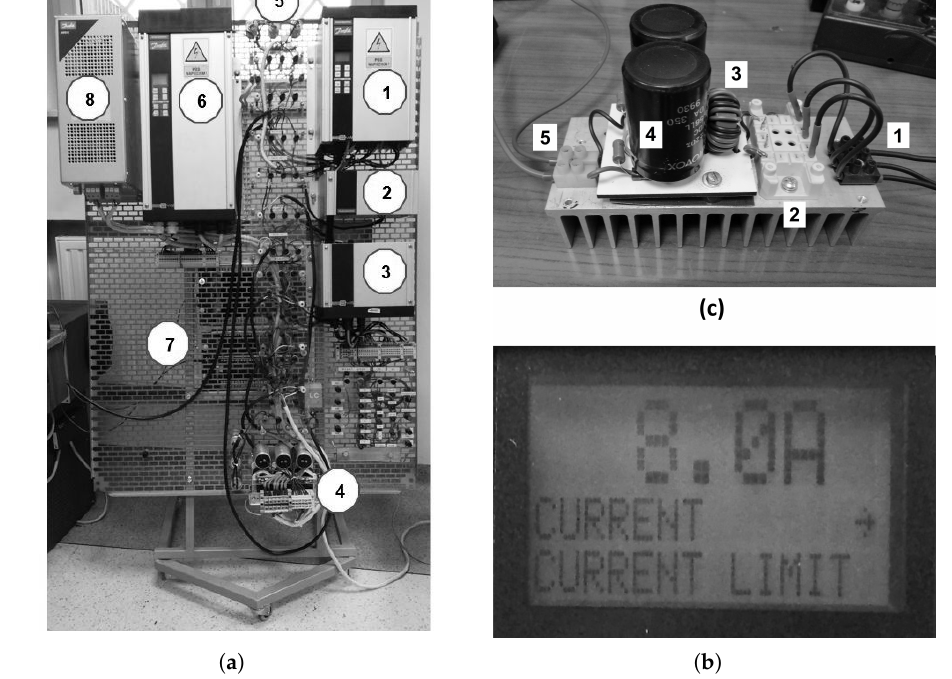
Figure 12. Laboratory stand: ( a ) equipped with two drive VFCs with built-in rectifying units